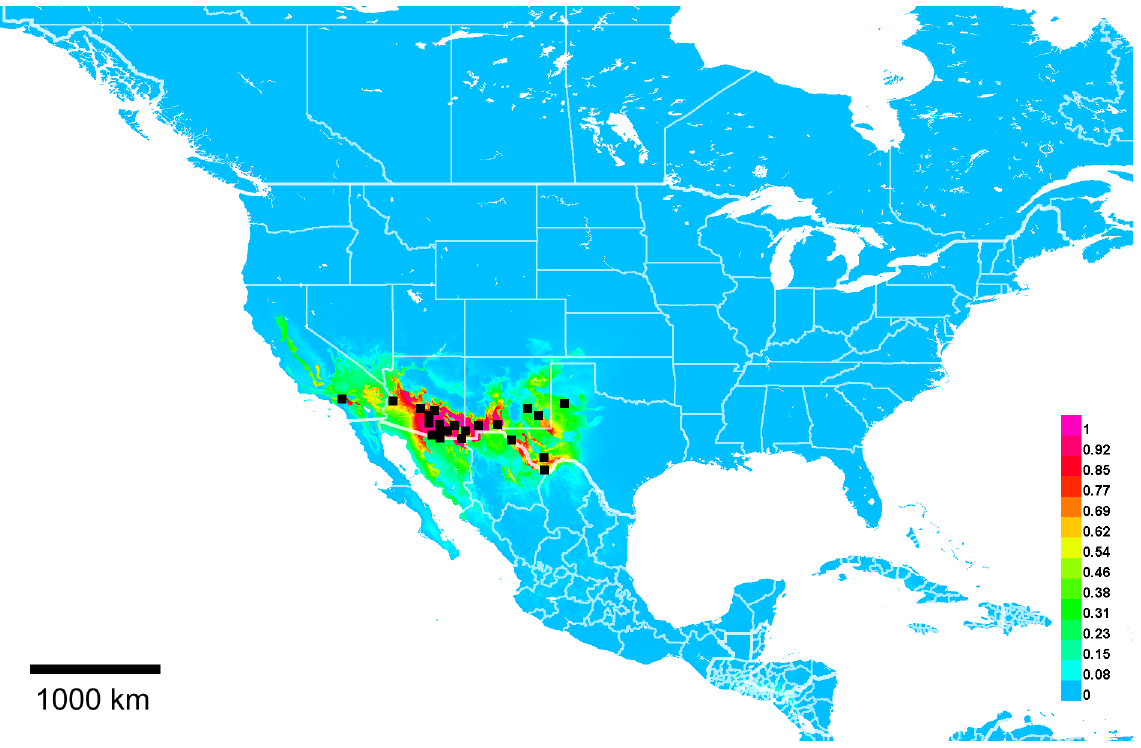
Fig. 38. Georeferenced collection records of Lasioglossum ( D .) indagator sp. nov. (black squares) and predicted distribution by maximum entropy ecological niche modelling in Maxent (colour shading). Warmer colours indicate higher cloglog probability of